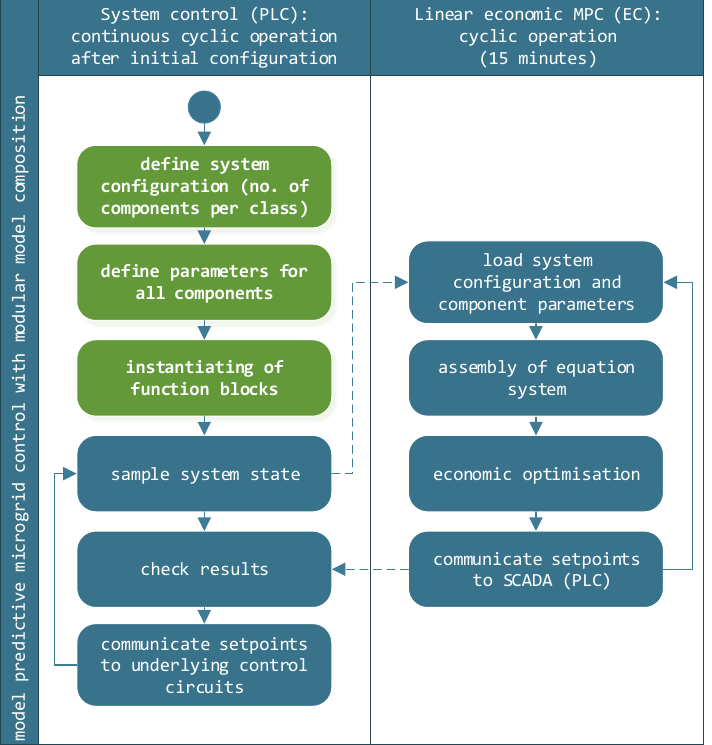
Figure 5. Flow chart of the scalable MPC implementation on PLC and EC. Initial configuration steps by the commissioning staff are highlighted green. Cyclic behaviour of the control components is highlighted blue. Dashed lines mark field-bus